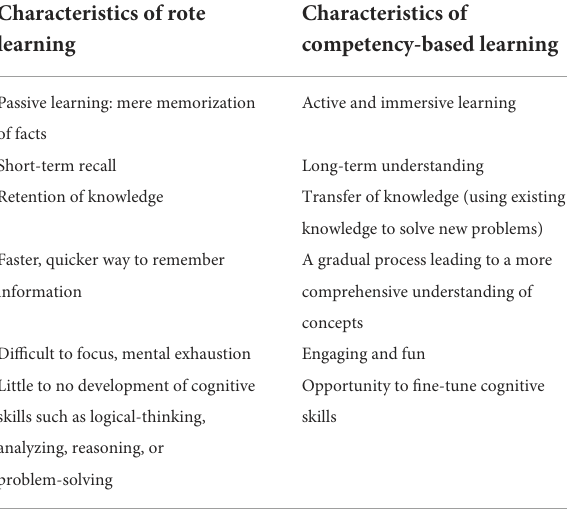
TABLE 1 A comparison of characteristics between rote learning vs. competency-based learning [adopted from Crosslin (2016)]. Characteristics of